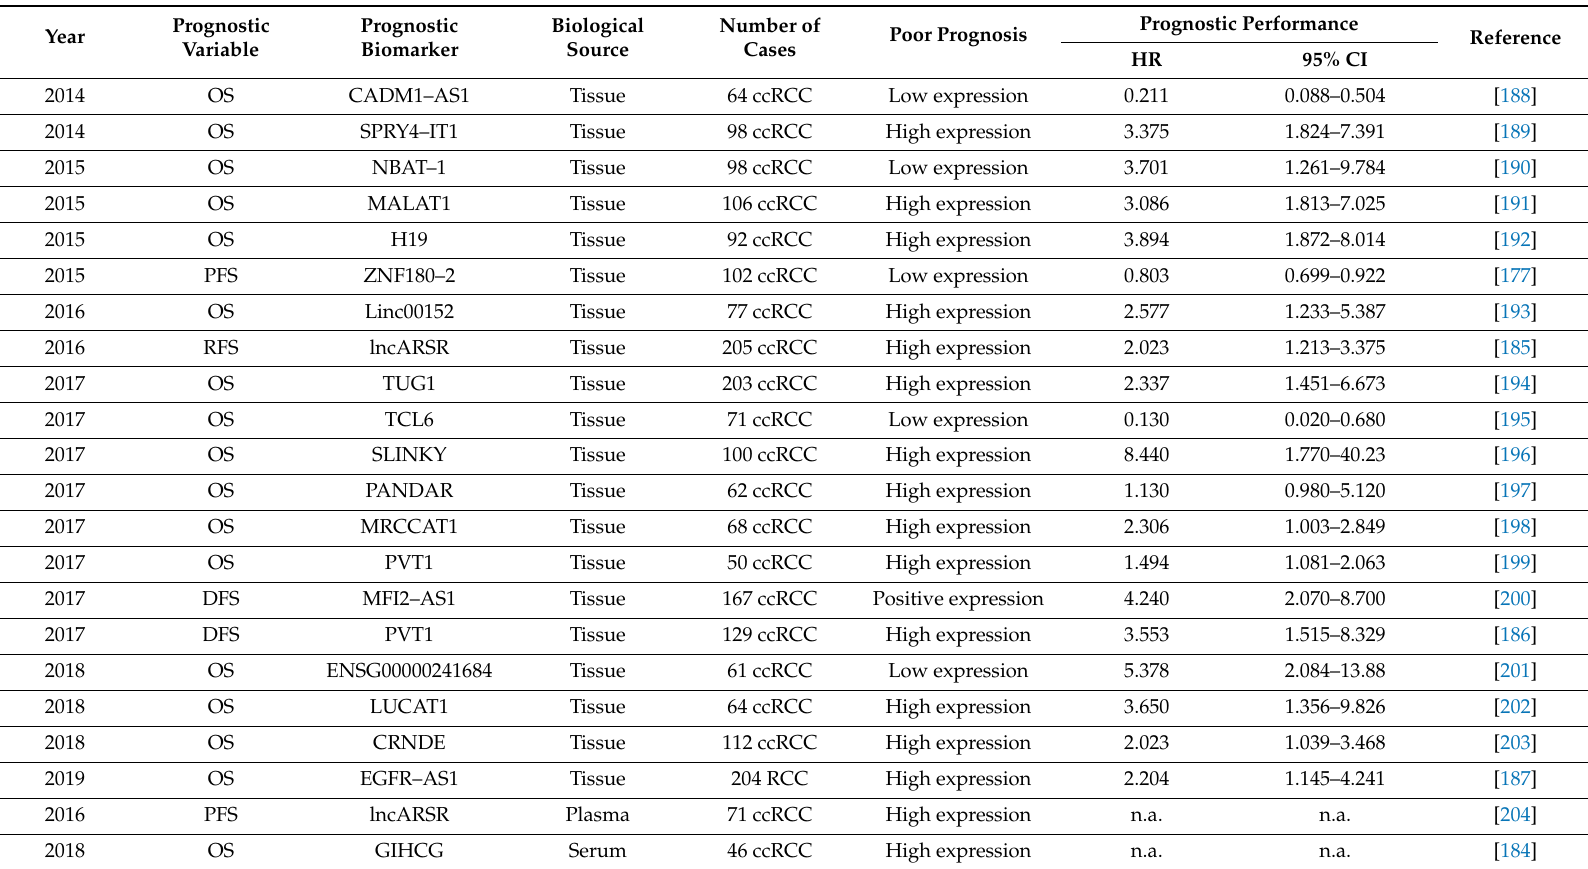
Table 7. LncRNAs as potential prognostic biomarkers in RCC